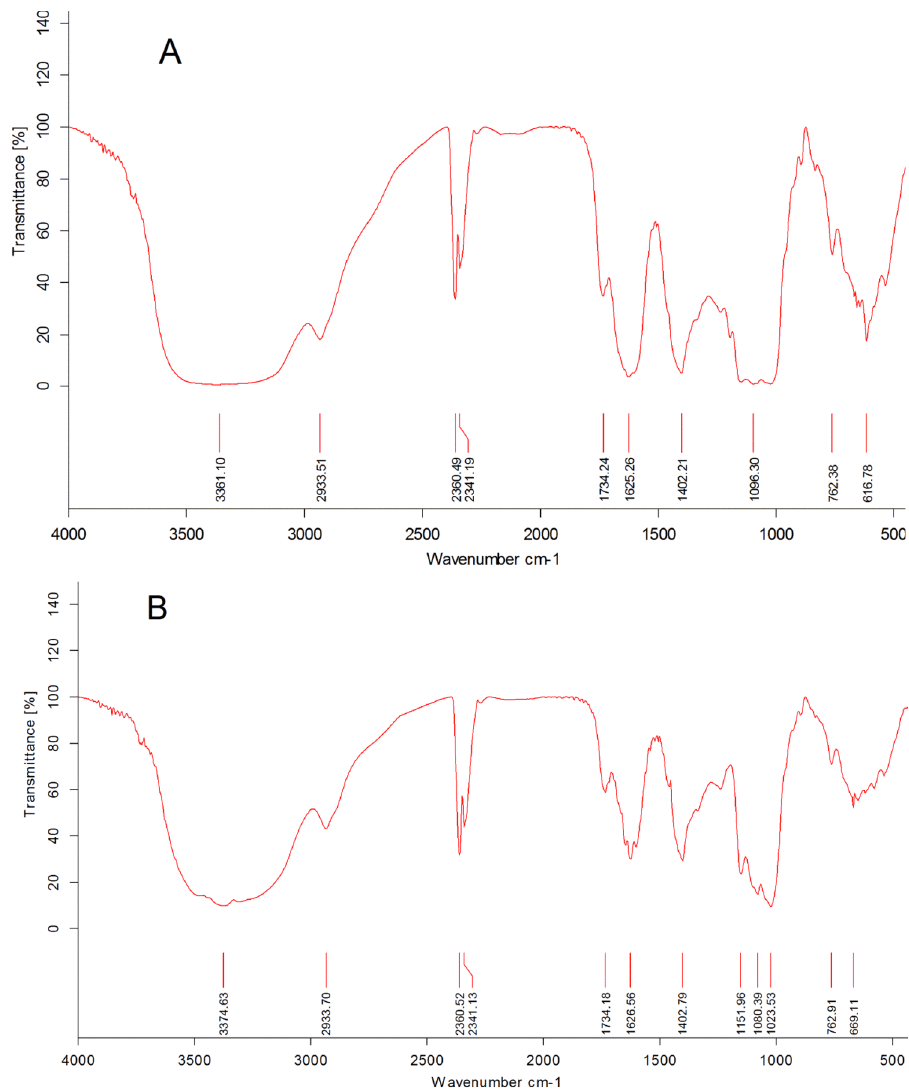
Fig 1. Infrared spectra of SCP (A) and SCP